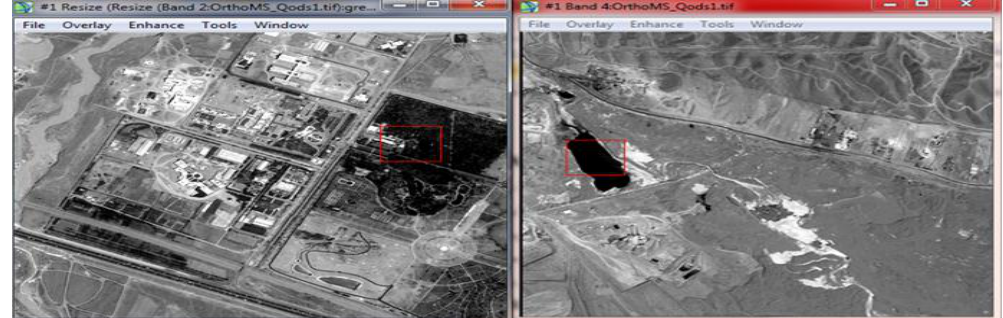
Figure 1. Separating image into green and infrared bands: the right image represents a body of water in the near infrared band and the left one shows trees in the red